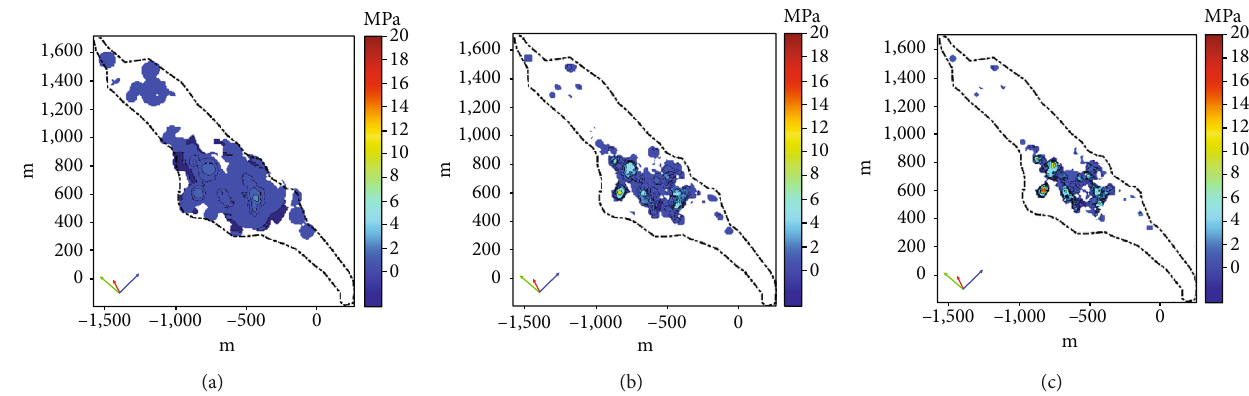
Figure 8: Spatial distribution of the maximum cumulative fl uid pressure changes inferred from repeated slip in top view of best- fi tting plane. Pressure changes are stated in megapascals according to the colour map, which is saturated at 20MPa. The 3D arrow indicates northern (green), western (red), and depth (blue) direction after projection and rotation of hypocentre locations. A constant stress drop of (a) 0.1 MPa, (b) 0.5MPa, and (c) 1.0 MPa was assumed for determining fl uid pressure changes. Contour line denotes region of main seismic